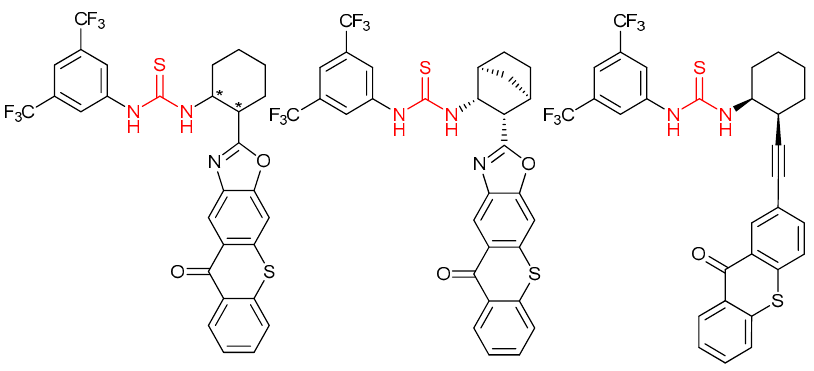
Figure 30. Chiral thioureas bearing thioxanthone fragment [334].